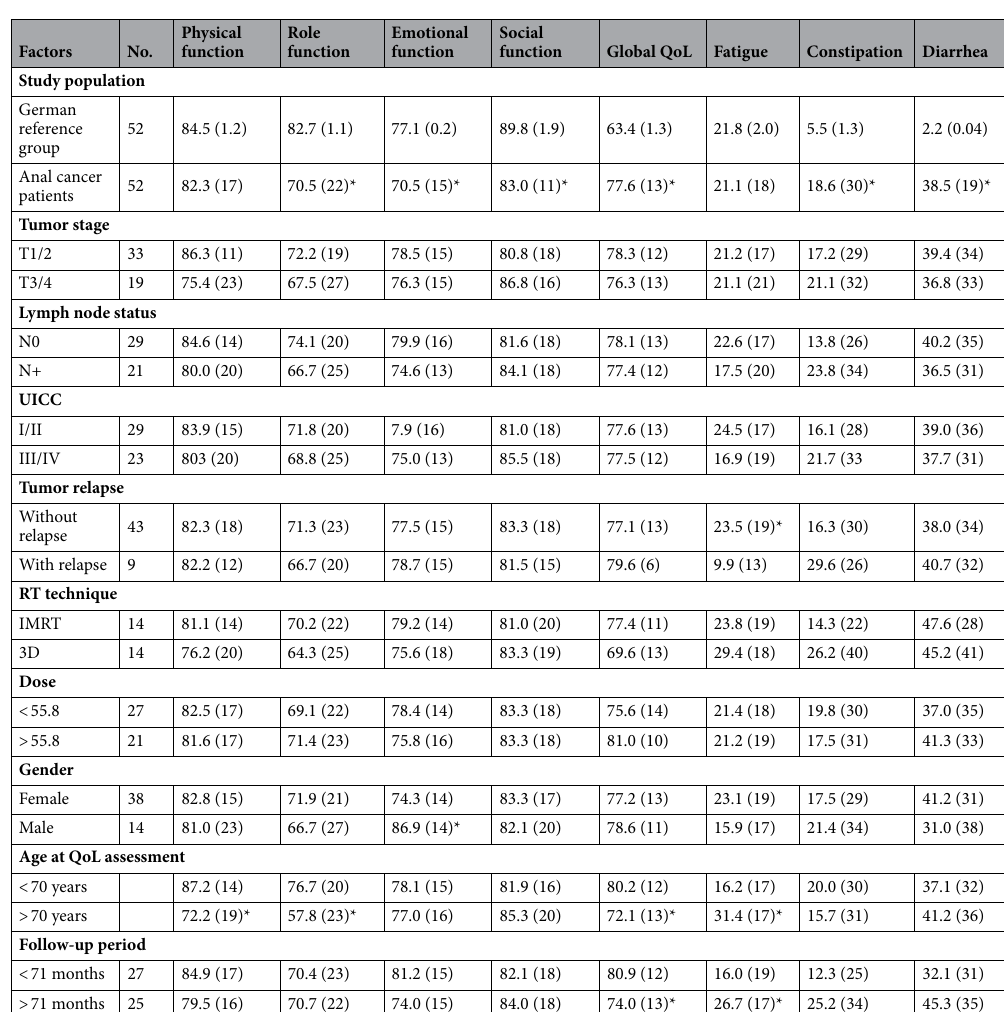
Table 2. QLQ-C30 questionnaire: patient-, tumor- and therapy-related factors. *Statistically significant. Standard deviation inside the